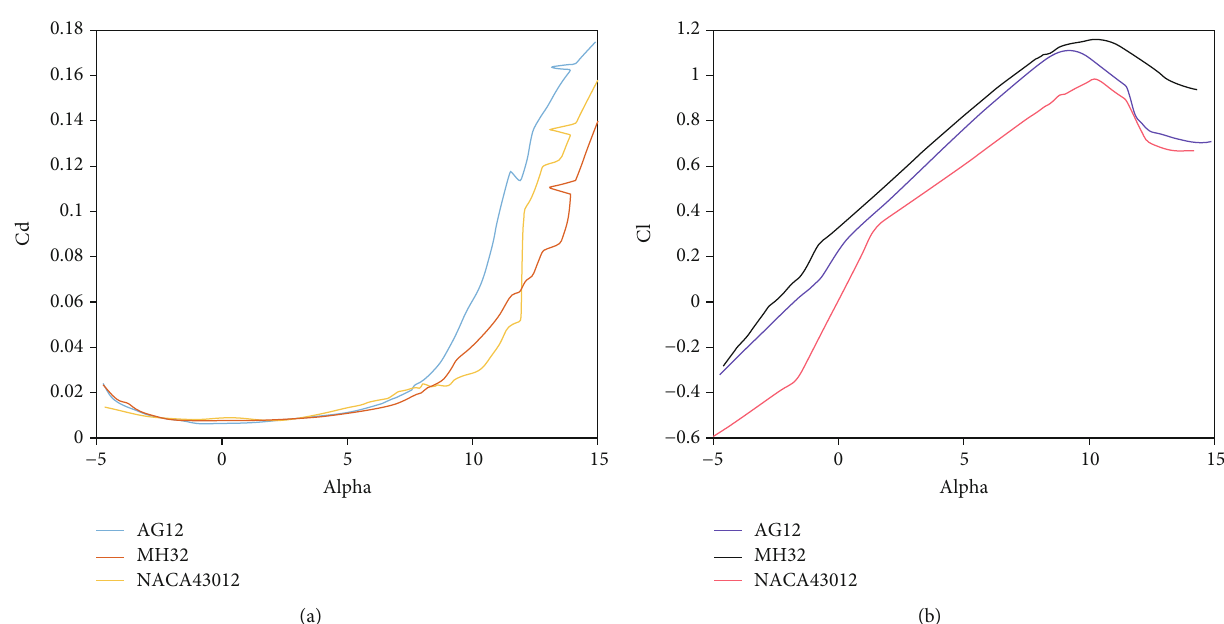
Figure 4: (a) Coe ffi cient of drag vs. angle of attack. (b) Coe ffi cient of lift with respect to angle of